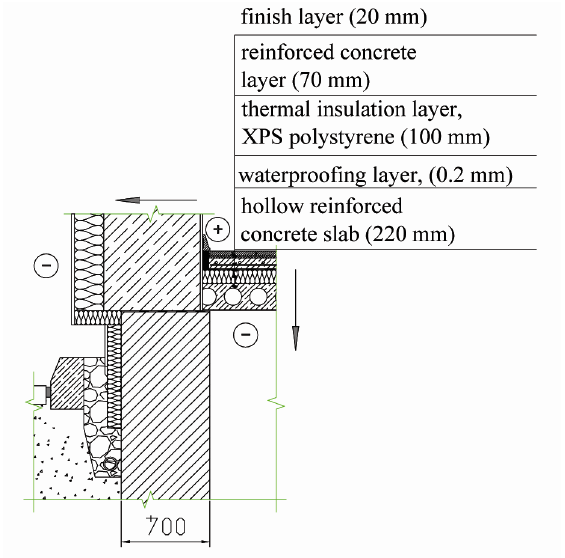
Fig. 6. Improvement of the thermal insulation layer (100 mm in width) on the ceiling of the building